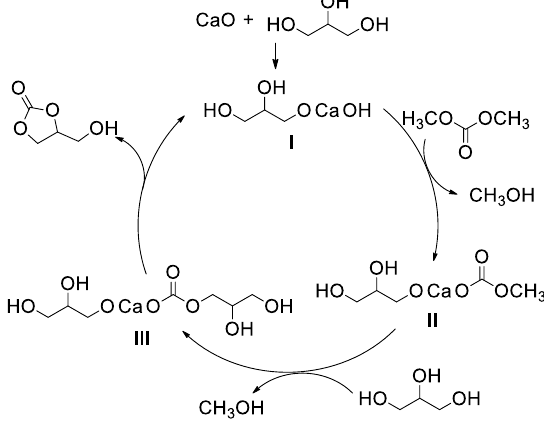
Figure 8. Plausible reaction mechanism for CaO-catalyzed transesterification of glycerol, (reprinted with permission from Reference [57], Elsevier, 2011).